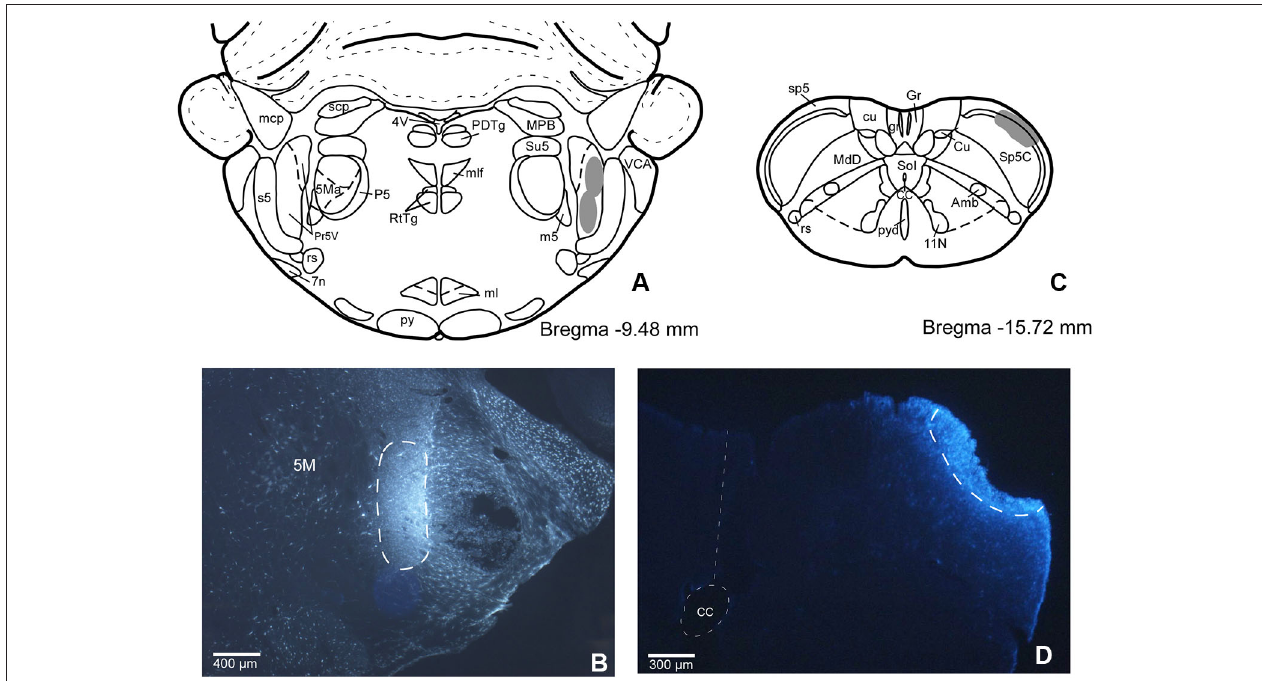
FIGURE 1 | (A) Schematic drawing of Bregma − 9.50 mm Paxinos and Watson Atlas. The gray area represents the summarized location in Pr5 of the FlGo injections in all cases. (B) Microphotograph of a coronal section in animal RE11 showing the injection side in Pr5 (limited by dashed line). (C) Schematic drawing of Bregma − 15.7 mm showing the limits of the FB injection in Sp5C represented by gray area. (D) Microphotograph of a coronal section showing the injection site in Sp5C (limited by dashed line) in animal RE8. Calibration toolbar: B: 400 µ m, D: 300 µ m. Abbreviations: 11N: accessory nerve nucleus, 4V: 4th ventricle, 5M: motor trigeminal nucleus, 5Ma: motor trigeminal nucleus, masseter part , 7n: facial